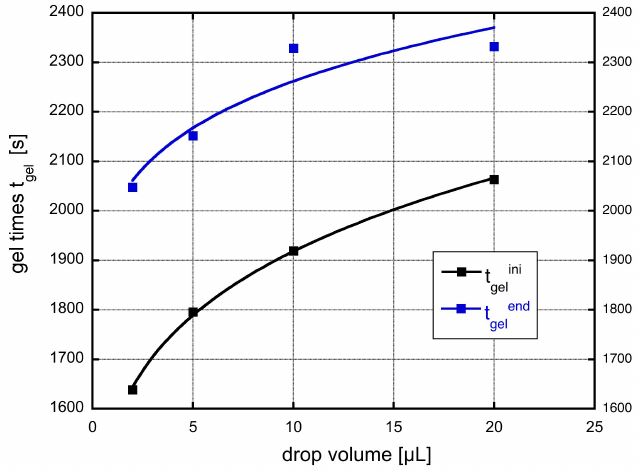
Figure 8. Measured gel-time compared with the theoretical expression given in Equation